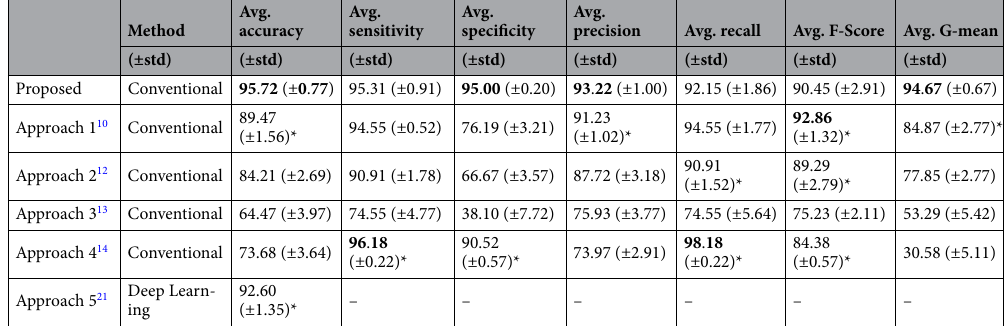
Table 4. Comparative classification performance of our proposed method in compared to state-of-the-art methods. *Significant difference in the corresponding evaluation metric between our proposed method and the corresponding method in paired sample t-test. Bold value indicating the best score of the corresponding evaluation metric (column) among all methods.